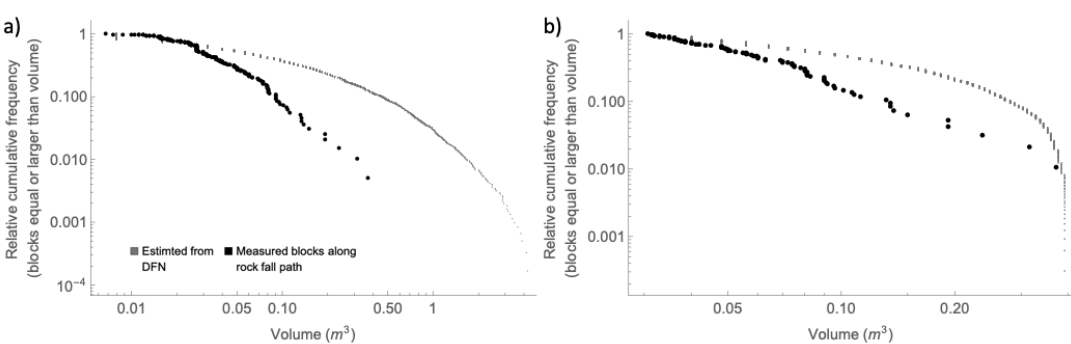
Figure 13. Fragmented rockfall volume cumulative relative distribution as calculated by the persistent DFN method and field surveys, for all DFN calculated volumes ( a ) and for DFN volumes truncated in accordance with the range of surveyed volumes ( b ). Site S042.